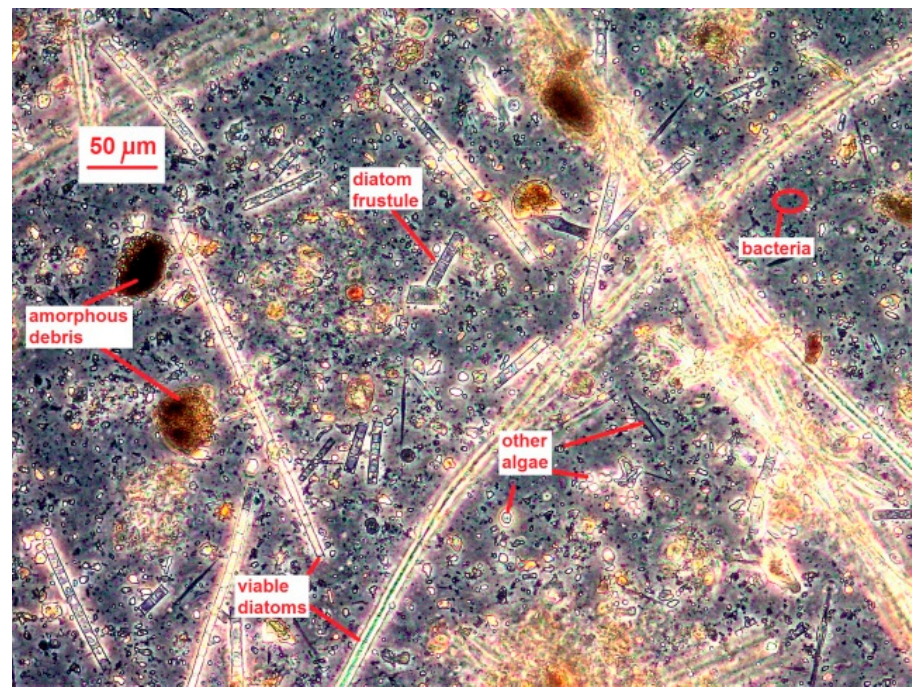
Figure 5 . Microscopic image (× 100 magnification) of backflushed material on 3 November 2017 (event B in Table 3), showing diatoms (incl. fragments), algae, mostly non-filamentous bacteria, and amorphous flocs.